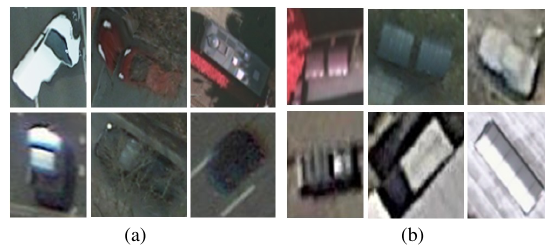
Table 1. Anchor information of our RPN and the original RPN at each possible location